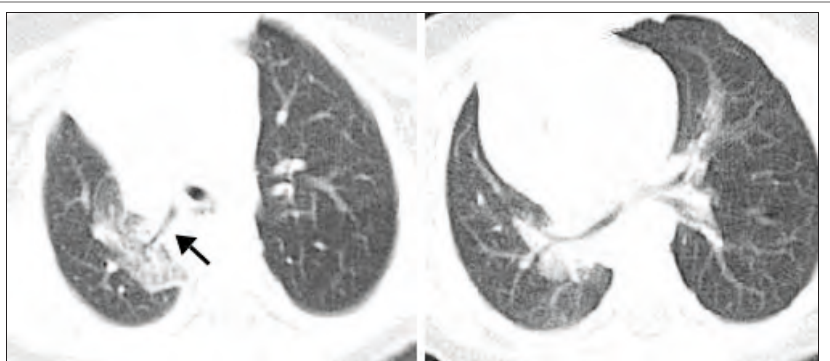
2. Axial CT of the chest – lung window demonstrates the tracheal bronchus (arrow) on the right, which supplies the posterior segment of the right upper lobe. This segment demonstrates ground-glass opacification and is possibly dysplastic. The image on the right is lower down, at the level of the carina, and demonstrates that the trachea distal to the tracheal bronchus is narrowed and the carina is low (at T5/T6 level). 1. Antero-posterior radiograph of